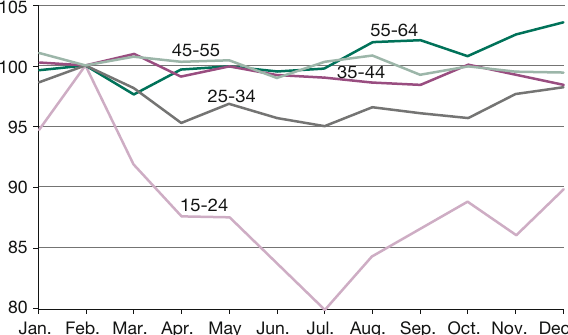
Note: The percentages indicate the share of furloughed workers relative to the total unemployment pool (furloughed and unemployed). Source: Swedish Public Employment Service and Swedish Agency for Economic and Regional Growth.